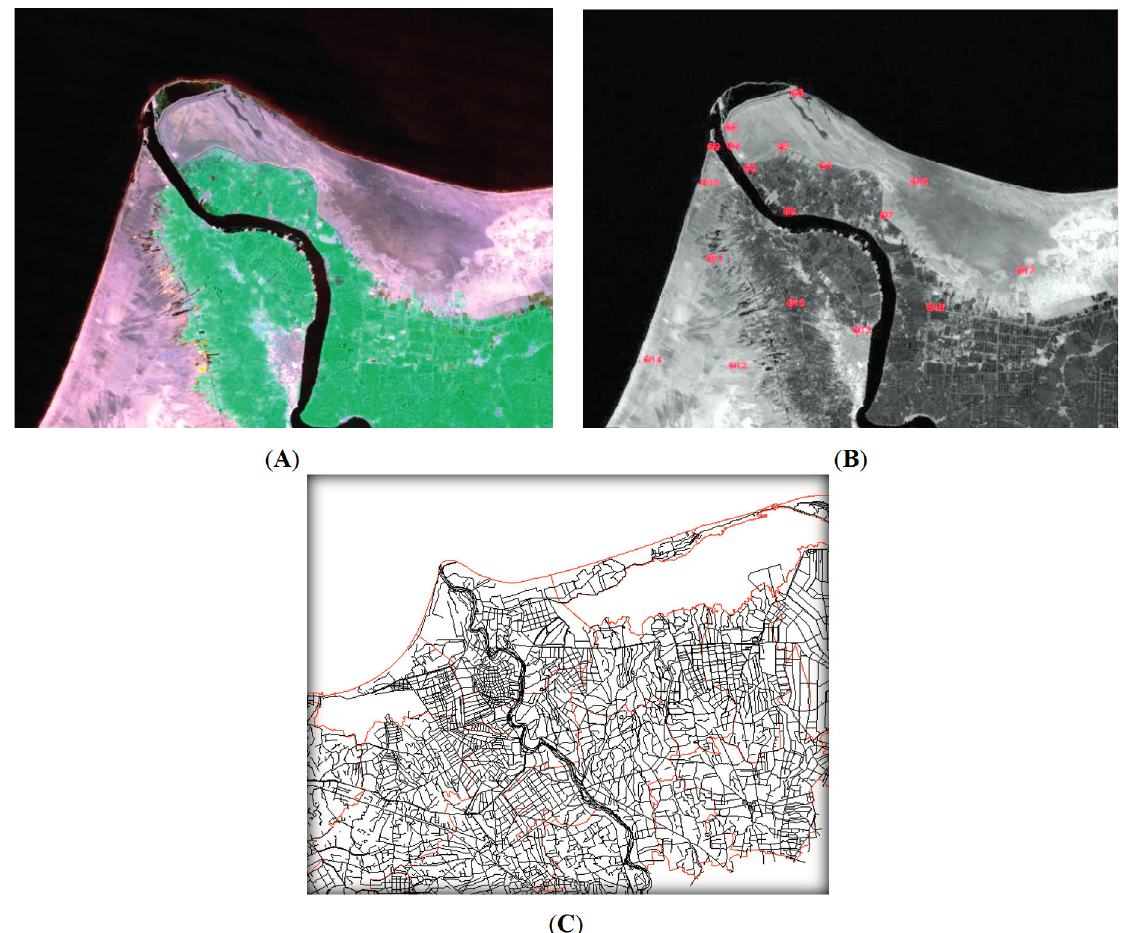
Figure 3. ( A ) Landsat image (1990) after clipping; ( B ) distribution of ground control points at the image(1990); and ( C ) a rectified digitized road map considered as the base map to geo-reference Landsat (1990), then the Landsat image (1990) was used as the master image for the other